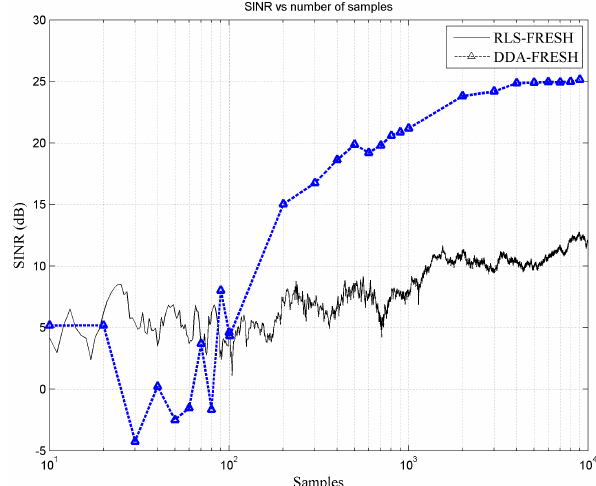
Figure 5. SINR vs total number of samples at SNR 5 dB and injection level − 5 dB, demonstrating comparative performance of RLS-FRESH and DDA-FRESH equalizers with regards to successive interference cancellation based NOMCR decoding.